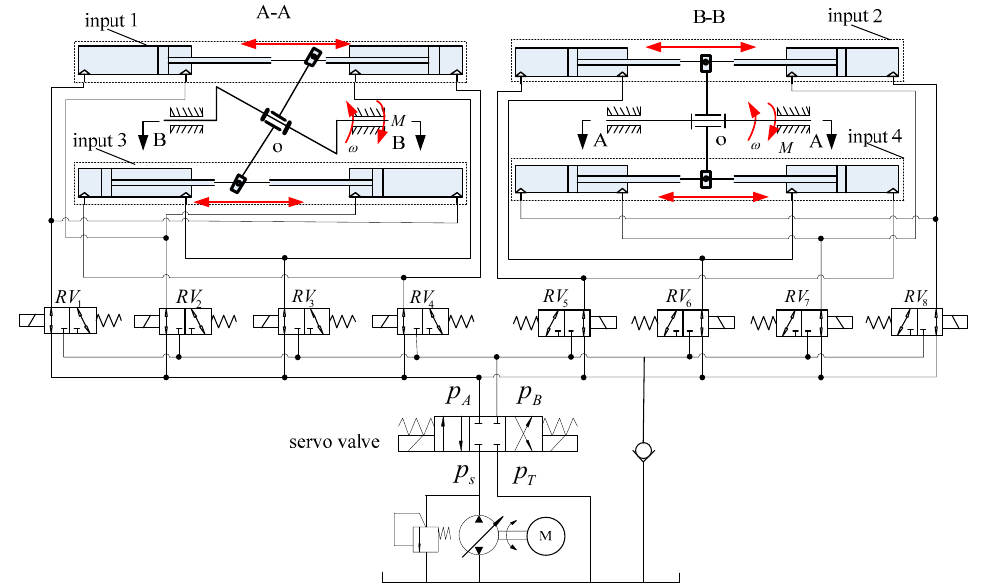
Figure 10. The diagram of the hydraulic system in the wobble plate joint.